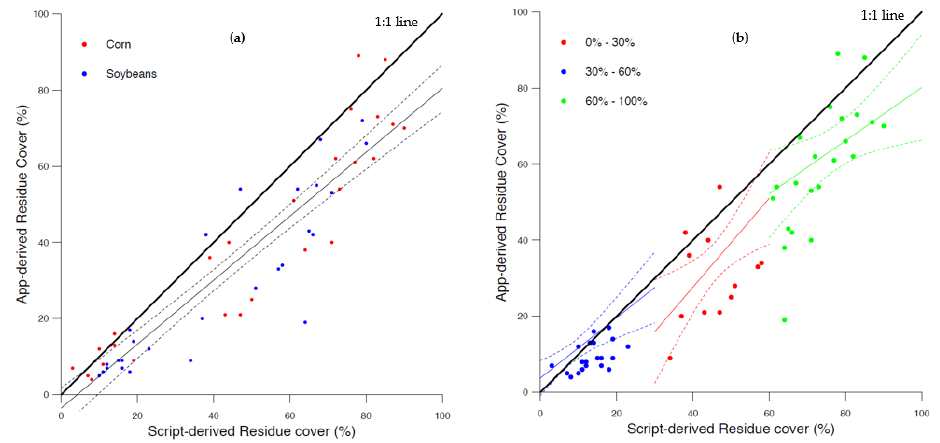
Figure 4. Relationships between residue cover percent as determined by script and app: ( a ) residue cover (corn = red dots and soybean = blue dots); and ( b ) residue levels (Low < 30%, medium= 30–60% and high > 60%). Related statistics (i.e., R 2 ) are shown in Table 3.